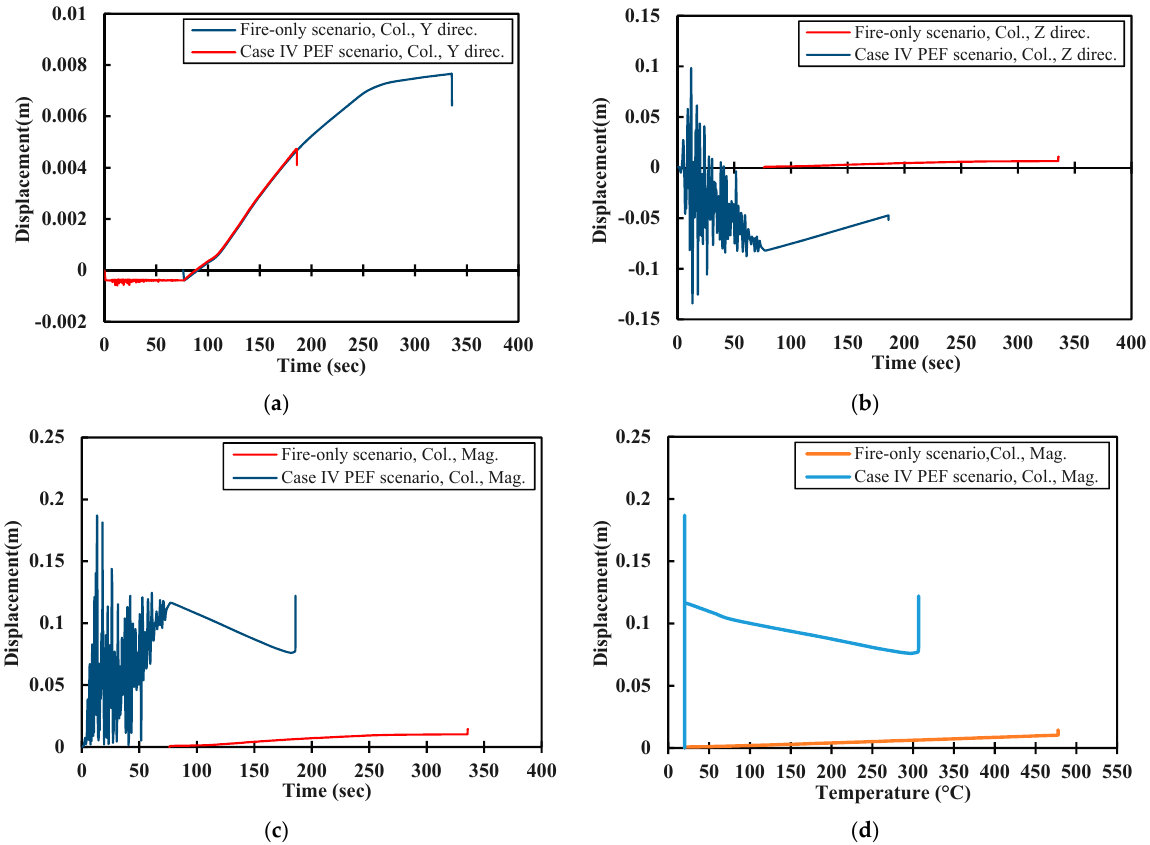
Figure 19. Comparison of the displacement values at a point which is 1.4 m along the column length for both the fire-only and PEF events for Case IV including ( a ) the time-displacement record in the y-direction, ( b ) the time-displacement record in the z-direction, ( c ) the time-displacement record for total displacement value and ( d ) the temperature-displacement record for the total displacement value.